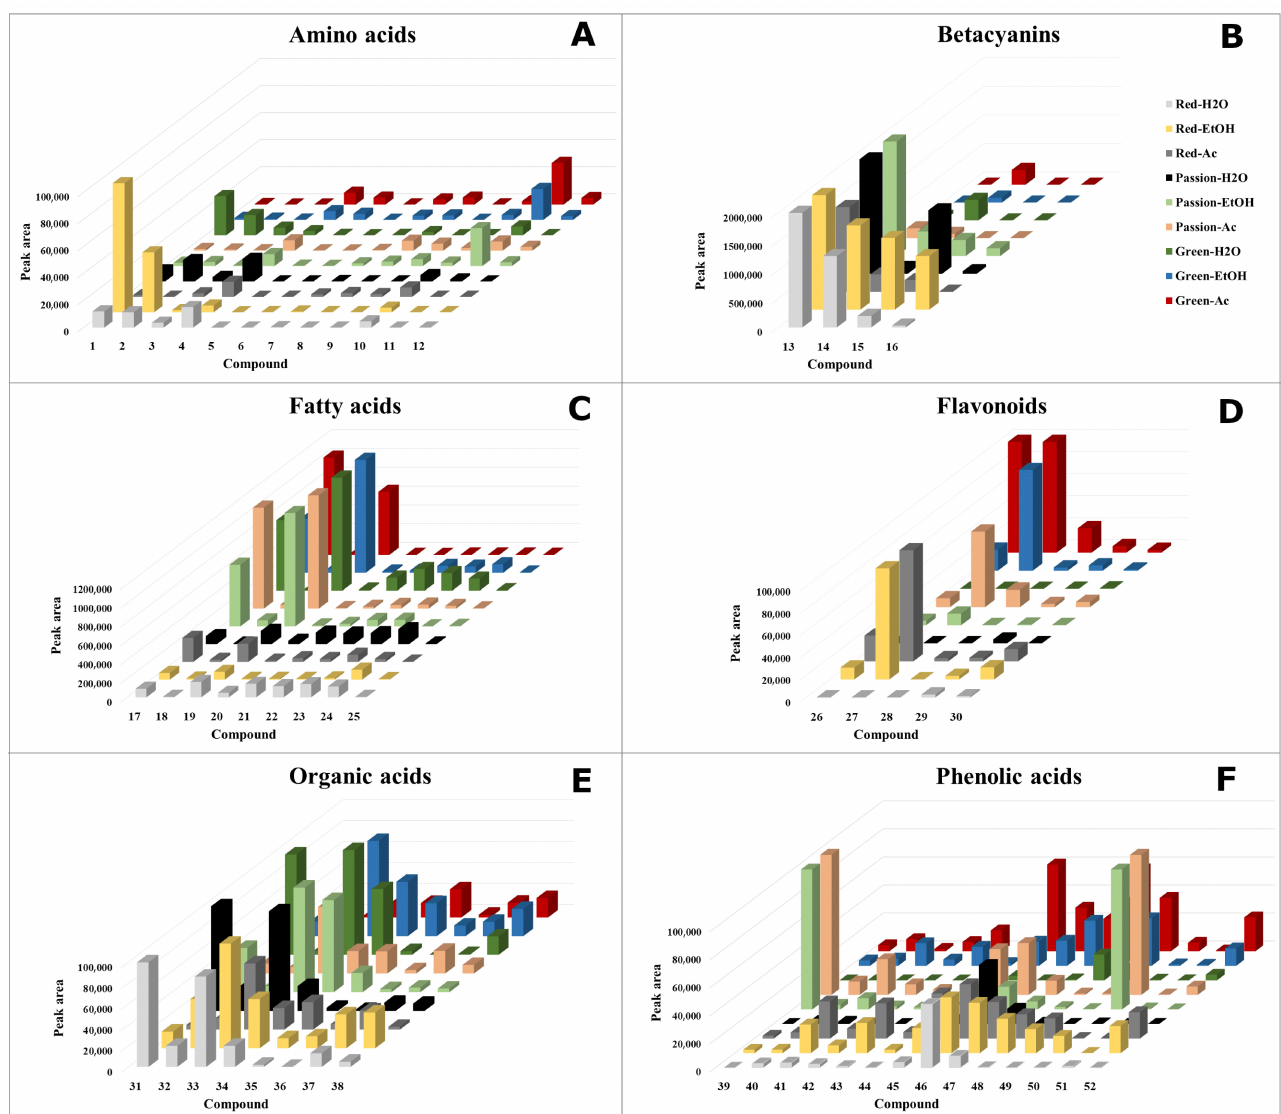
Figure 2. Absolute peak areas of identified metabolites of the Red, Green and Passion variety